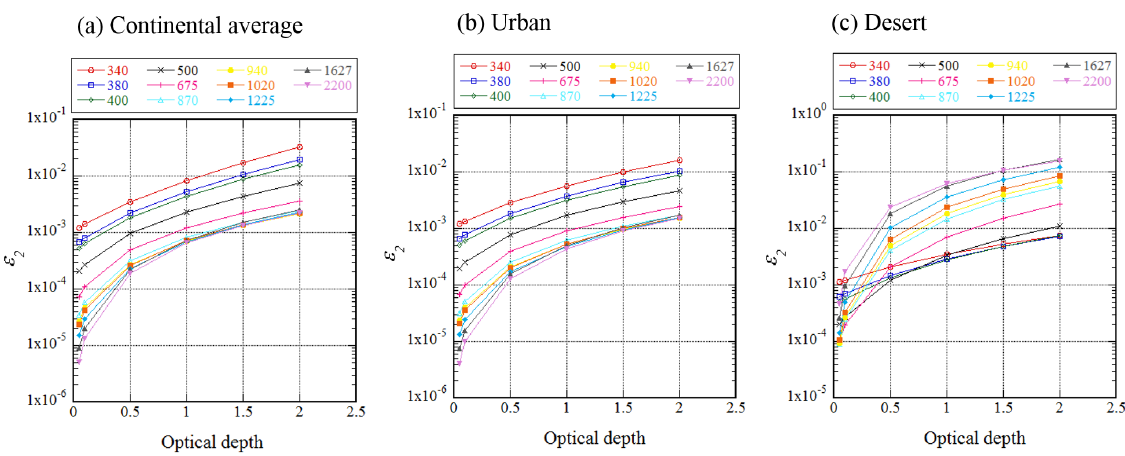
Figure 2. Estimation of the error ε 2 in the calculation of the SVA. Aerosol models are the OPAC continental average, urban, and desert. The aerosol optical depth thickness is that at a wavelength of 550nm and the solar zenith angle is 30 ◦ .